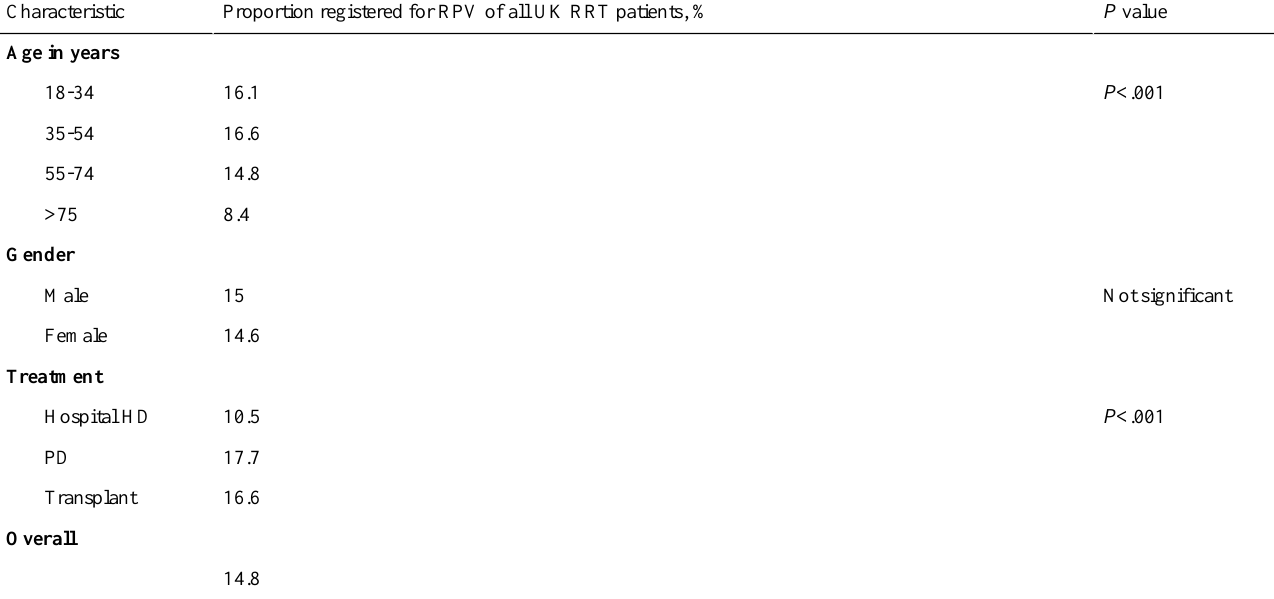
Table 3. Description of the RRT-dependent subgroup (n=6646) of the RPV-registered population compared with the overall UK RRT population by age, gender, and treatment (N=44,649) a